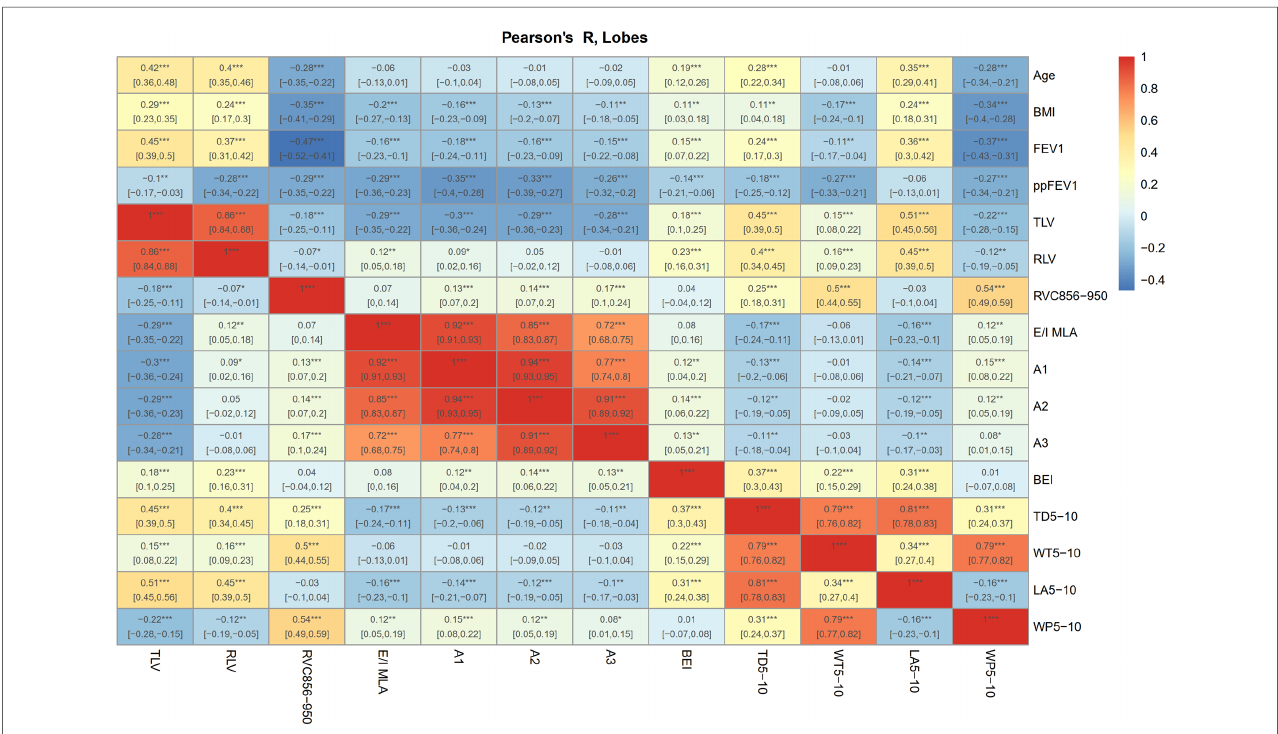
FIGURE 2 Correlation heat map of airway parameters and air trapping. Age, BMI, spirometric data FEV1 and ppFEV1, airway parameters (BEI, TD 5 − 10 , WT 5 − 10 , LA 5 − 10 , WP 5 − 10 ), lung volumes (TLV, RLV) and air trapping parameters (RVC856-950, E/I MLA, A1-3) were correlated across all time points and lung lobes. Dark red shows strong positive correlations and dark blue shows strong negative. *** P <0.001; ** P <0.01; * P <0.05. 95% con fi dence interval in brackets. Benjamini-Hochberg method was used for adjustment for multiple testing (26). Correlation heat maps for the individual lobes are shown in Supplementary Figures S1A – G .